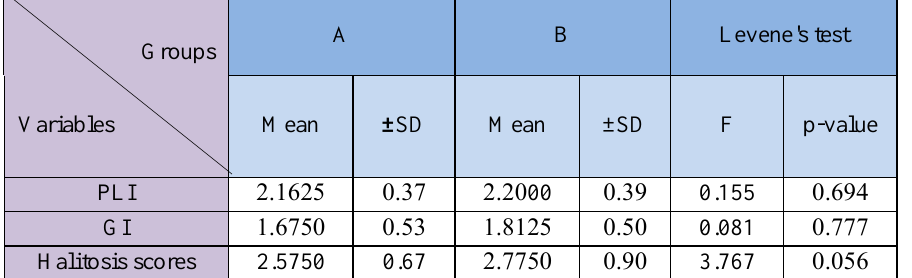
Table 2: The mean values of the variables of the sample among the groups at baseline examination